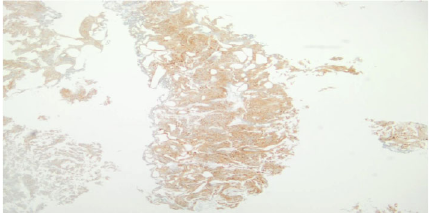
Figure 4: Malignant cells showing high positivity of synaptophysin marker on immunohistochemistry.